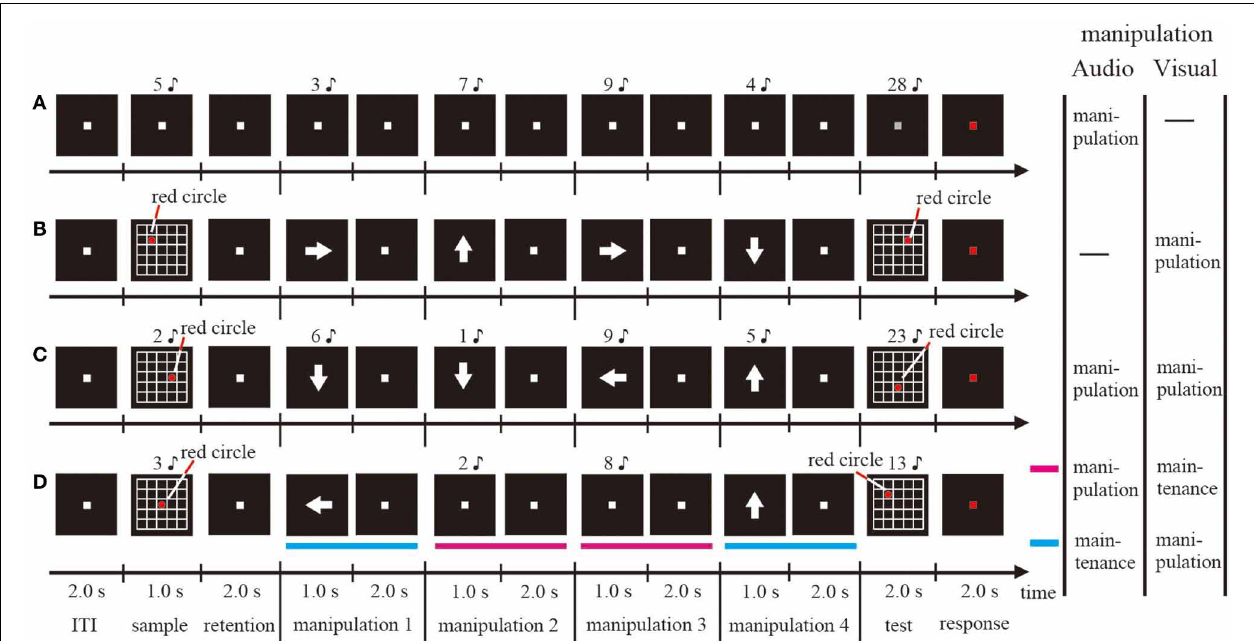
FIGURE 1 | Schematic illustrations of one trial sequence for the visual single WM (A), the auditory-verbal single WM (B), the simultaneous WM (C), and the sequential WM (D) tasks.